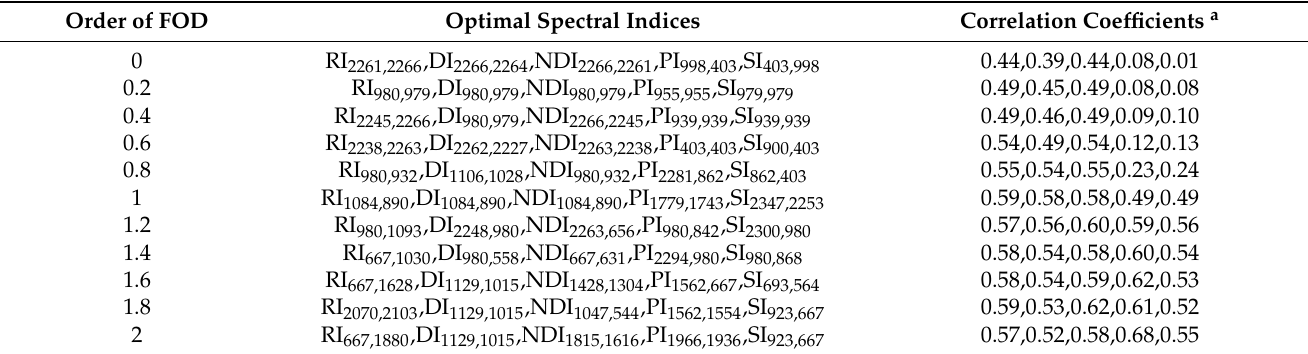
Table 4. The bands and correlation coefficient of optimal spectral indices for Cu.